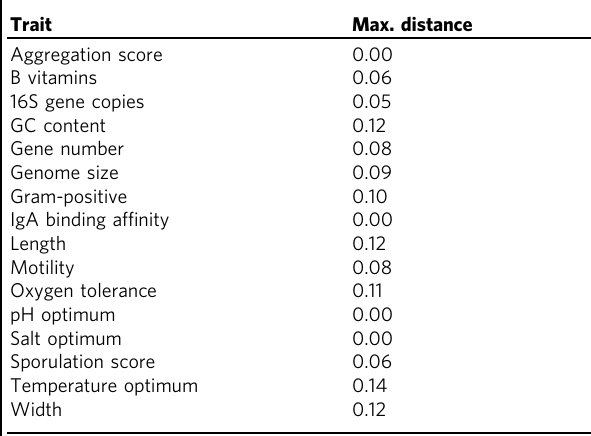
Table 2 Maximum phylogenetic distances used to infer trait